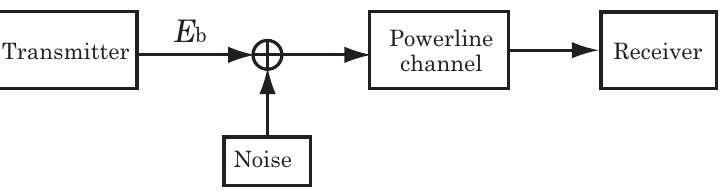
Figure 9. Schematic diagram of the model investigated